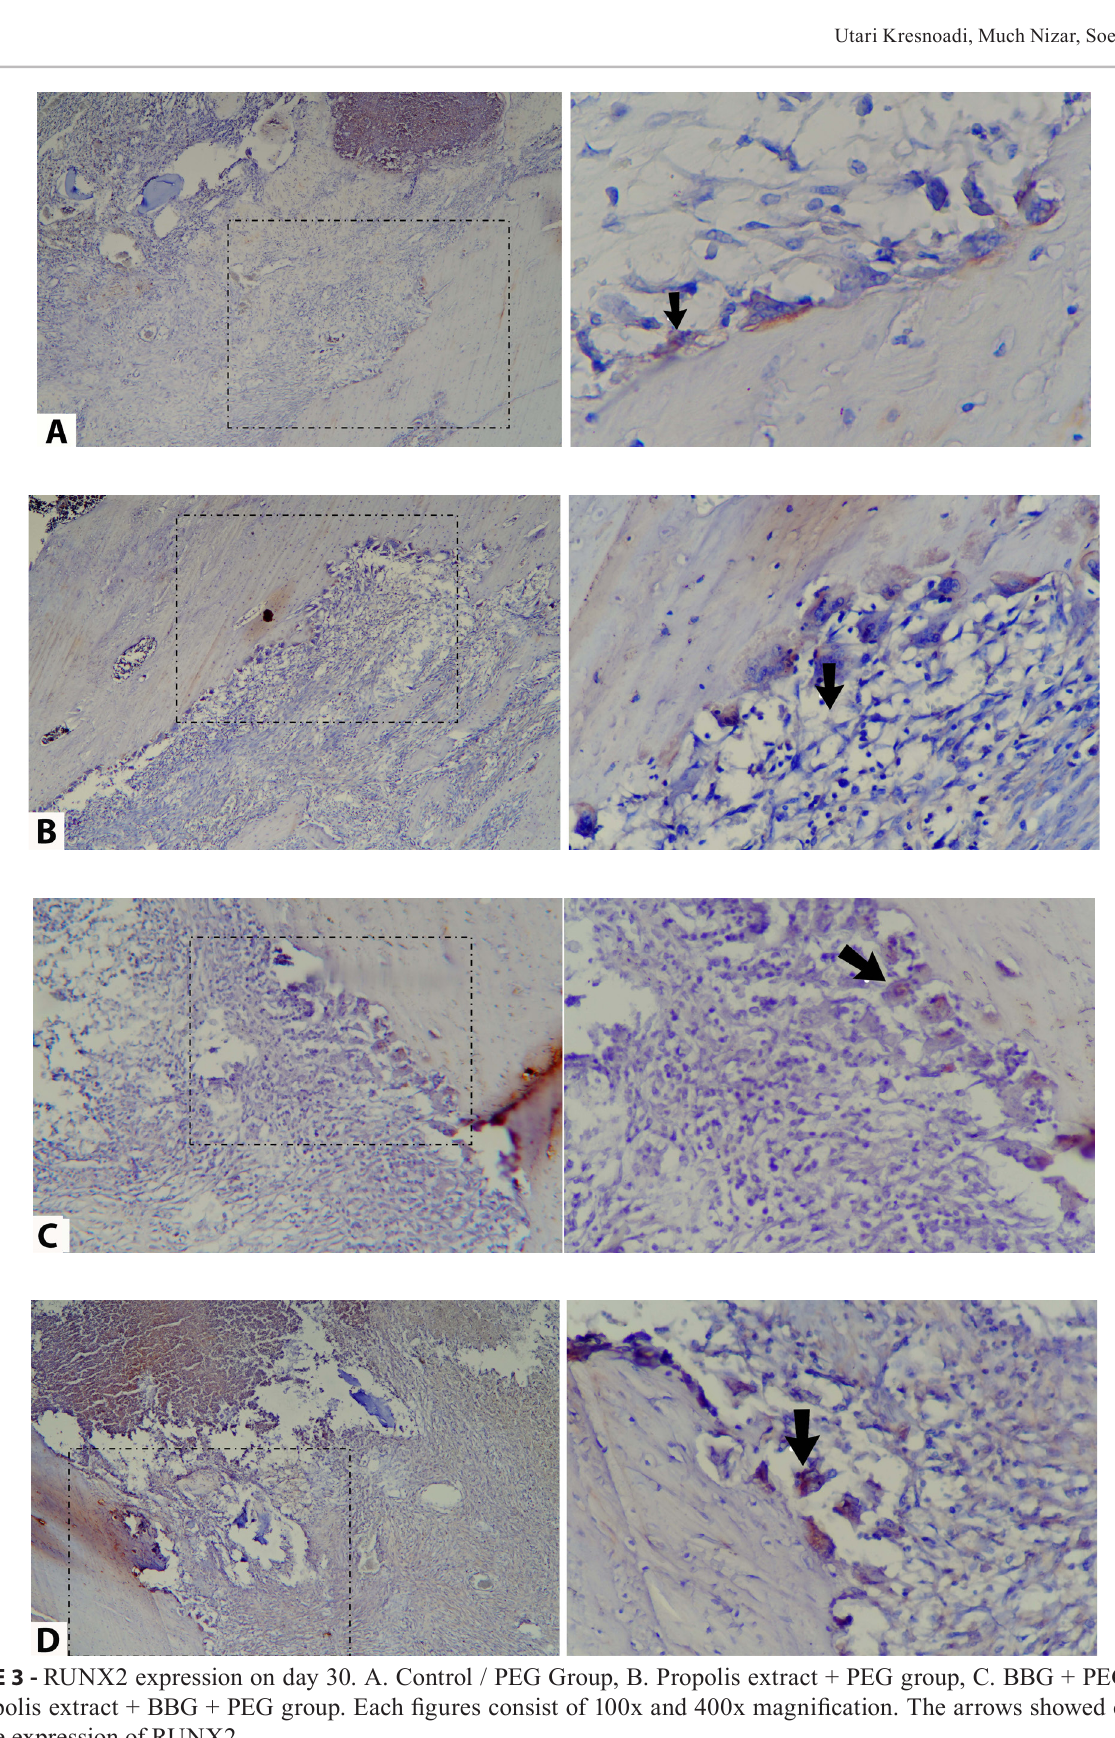
FIGURE 3 - RUNX2 expression on day 30. A. Control / PEG Group, B. Propolis extract + PEG group, C. BBG + PEG group, D. Propolis extract + BBG + PEG group. Each figures consist of 100x and 400x magnification. The arrows showed cell with positive expression of